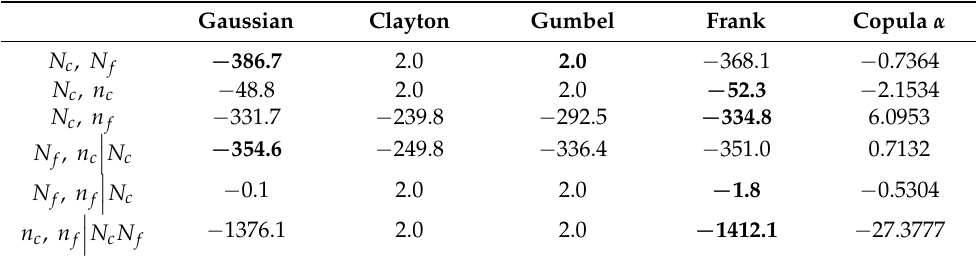
Table 10. Values of parameter estimation and AIC method ( N =